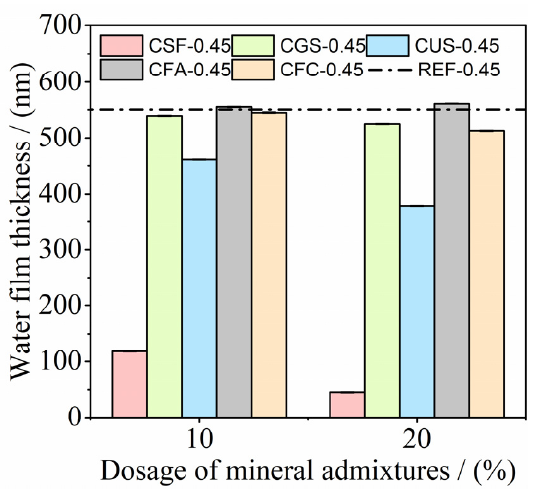
Figure 8. The water film thickness of common pastes.